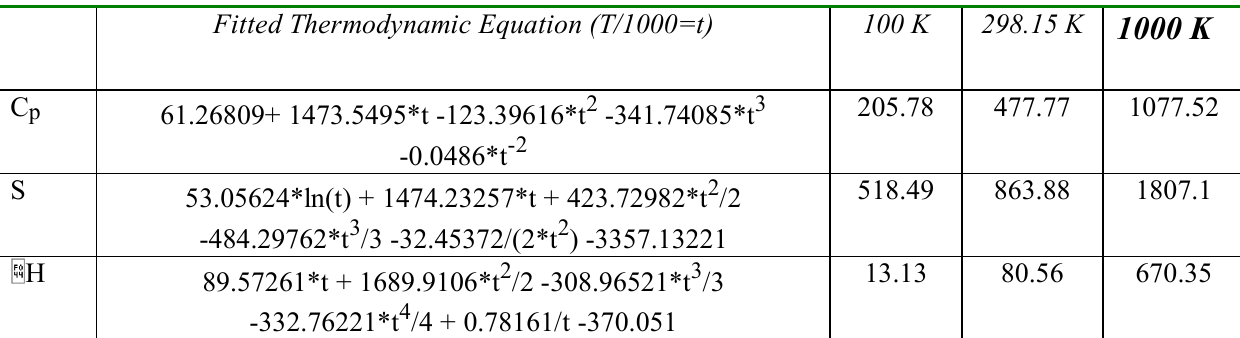
Figure 1. AM1 optimized structure and its theoretical IR vibrational spectrum for molecule 3 .